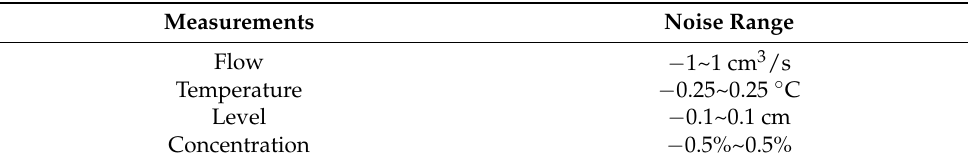
Table 2. Measurement noise.